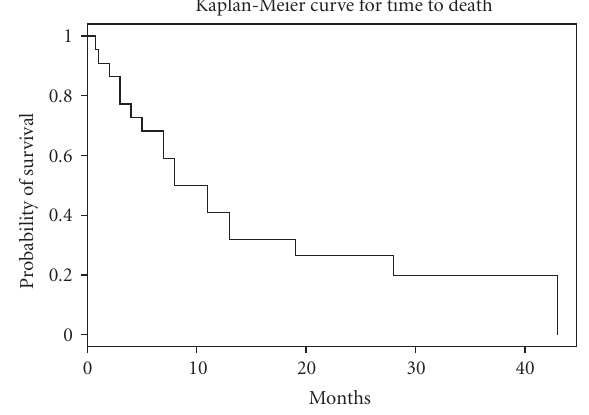
Figure 2: Overall